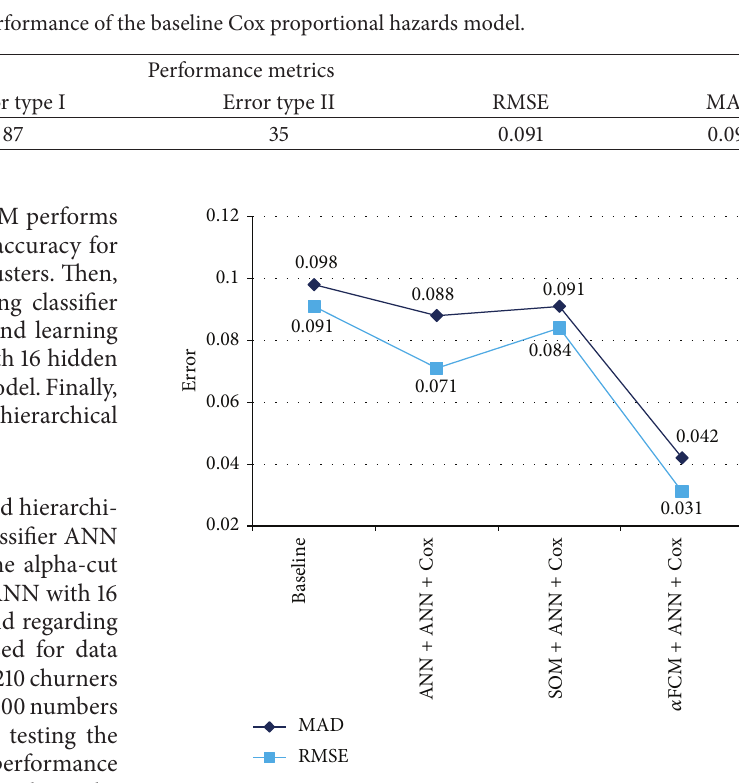
Figure 5: The RMSE and MAD errors of hierarchical